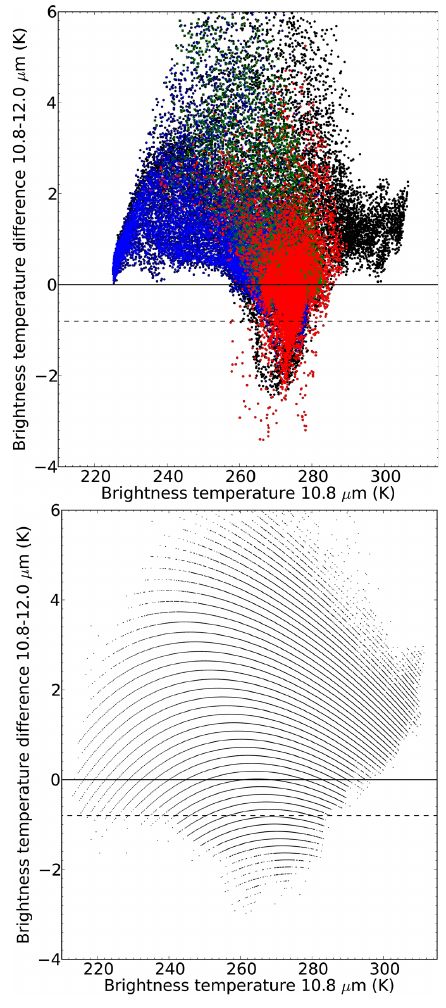
Fig. 6. Top panel: the MYSTIC simulated 10.8µm brightness tem- perature versus the 10.8–12.0µm brightness temperature difference. Blue, green and red points indicate pixels with ice, water and ash clouds as the uppermost cloud. Black points represents cloudless pixels. The dashed horizontal line indicates the ash limit cut-off. Bottom panel: similar to left panel, but data from SEVIRI. The line structures in the SEVIRI data are due to digitization. The Sahara desert has been excluded from both panels.